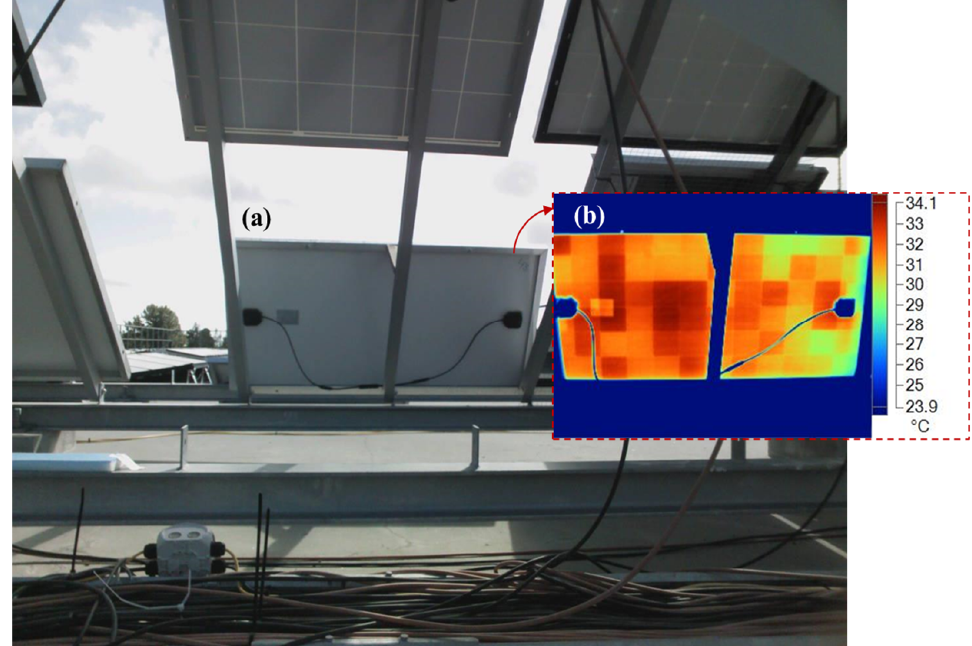
Figure 3. ( a ) Visual image and ( b ) IR thermal image (insert) of a PV module measured from the backside during the outdoor IR thermal imaging. The supporting metal trestle (behind the PV module) and the cables in the visual image show corresponding blue traces in the IR thermal image.